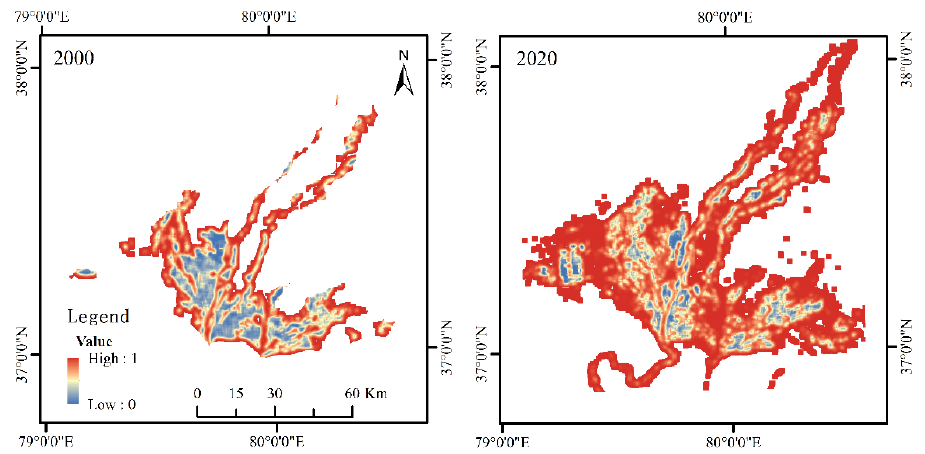
Figure 4. Spatiotemporal distribution of farmland landscape fragmentation.